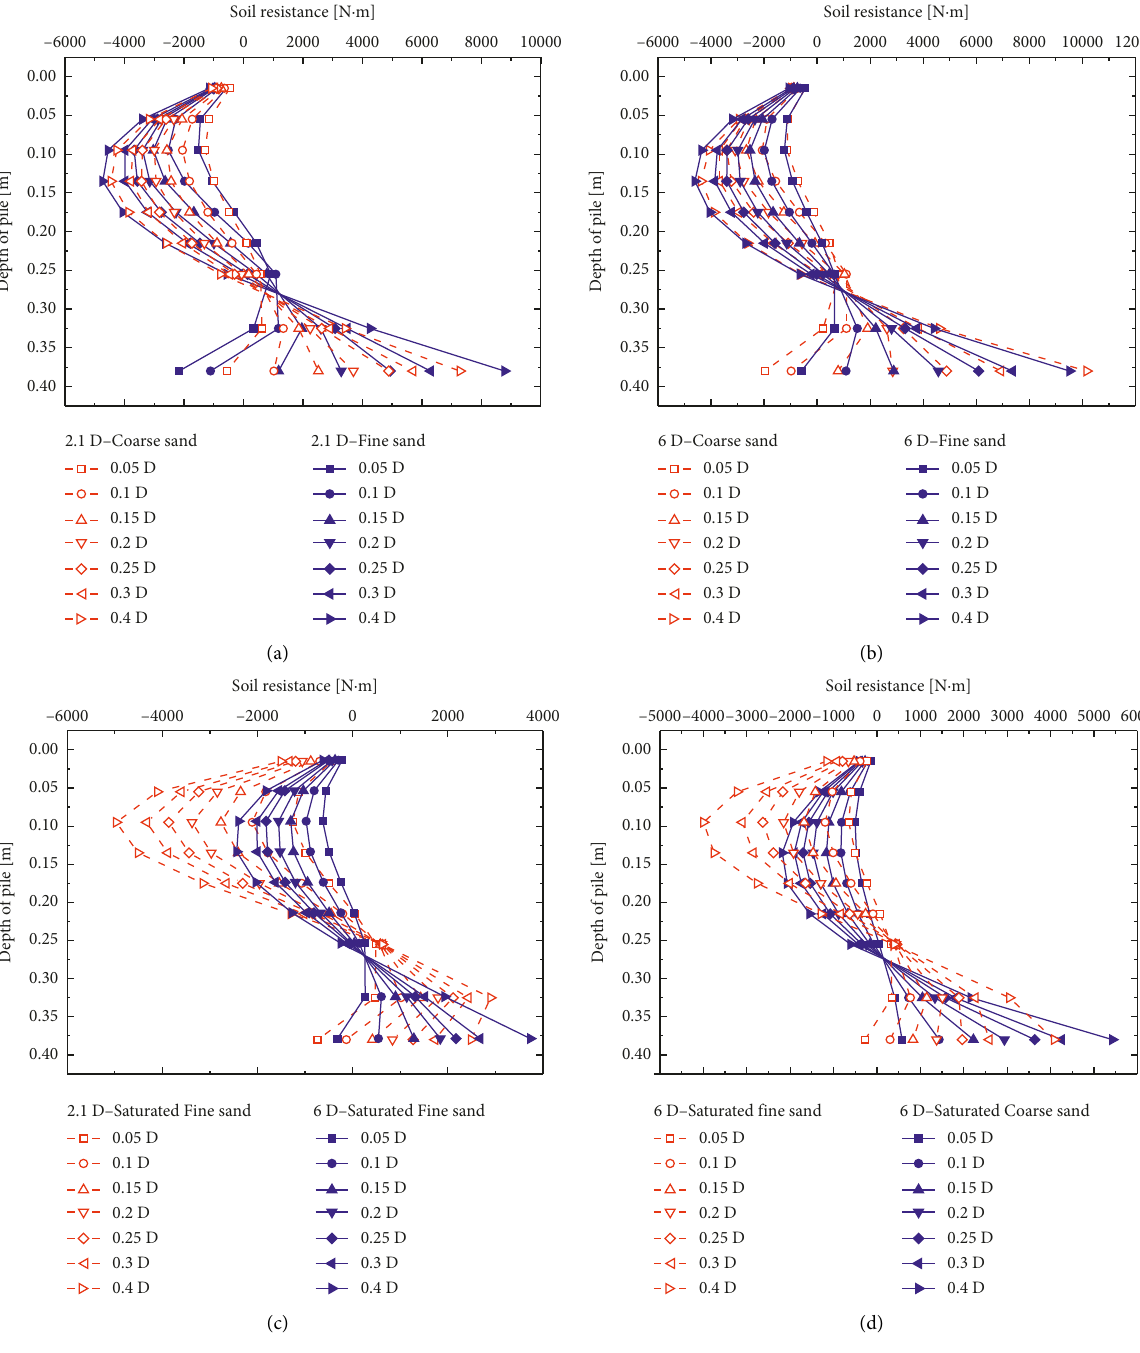
Figure 9: Comparison of pile soil resistance in fine and coarse sand. (a) 2.1D dry sand, (b) 6D dry sand, (c) 2.1D saturated sand, and (d) 6D saturated